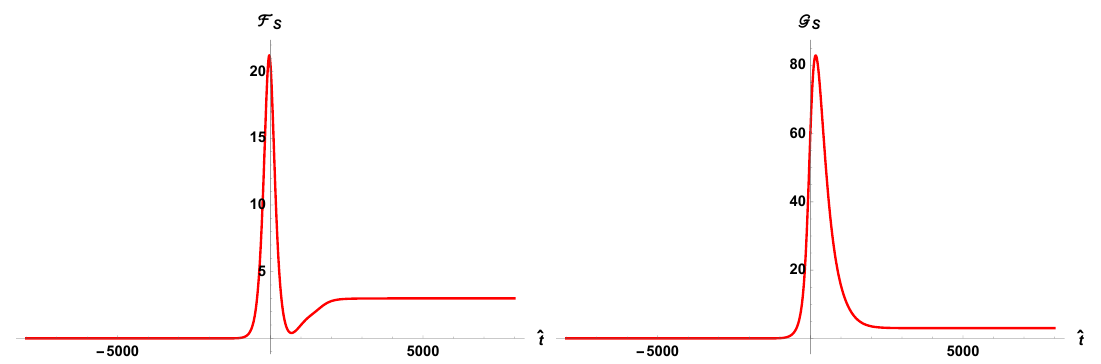
Figure 13 . Coefficients F S (left panel) and G S (right panel) for the model of appendix F: contrac- tion, bounce and subsequent GR kination.